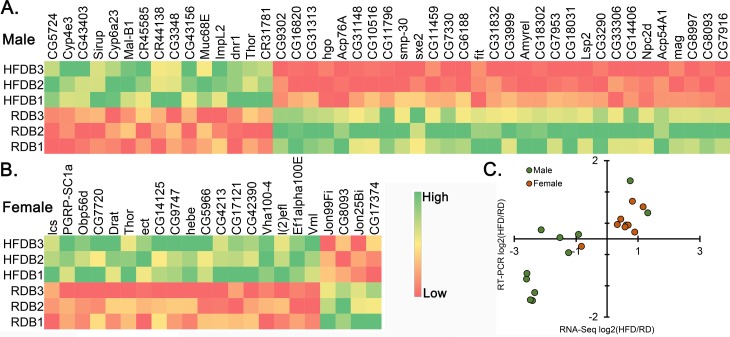
Heat map of differentially expressed genes in the bodies.Heat map of differentially expressed genes in the males (A) and female (B) body based on of RNA-seq (TPM values). The gene with P<0.001 in box. (C) Relative ration of HFD vs RD in the RNA-Seq (X-axis) compared to RT-PCR (Y-axis) results (S3 Table). Green color, upregulation; red, downregulation.